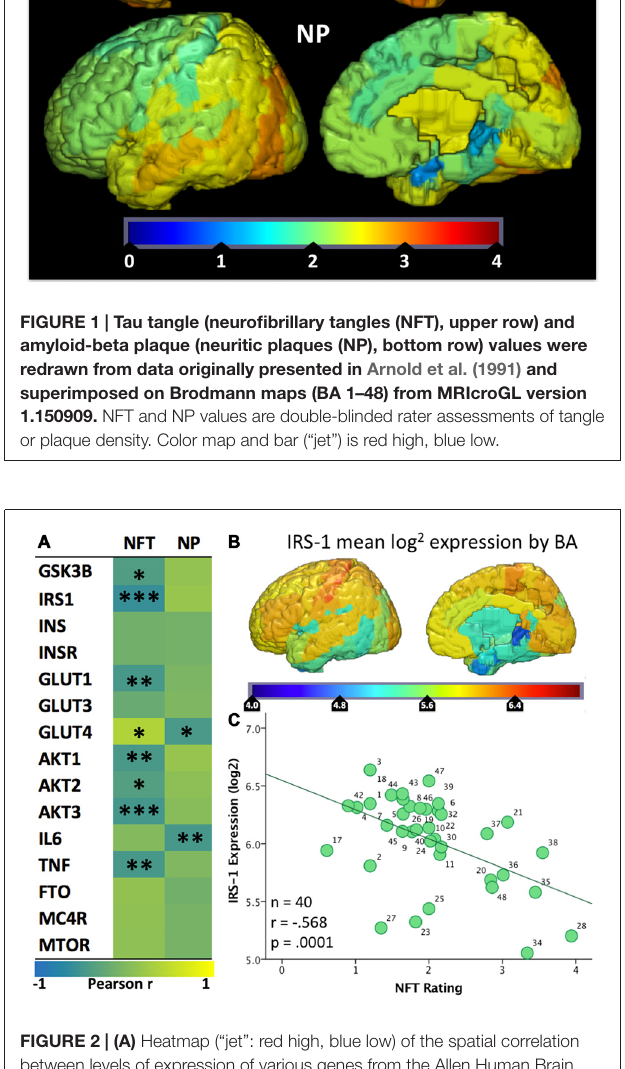
tangles in AD and lower expression in less vulnerable regions. A strong and significant positive association was seen between NFT density and expression of GLUT4 ( r = 0.39, p = 0.018).